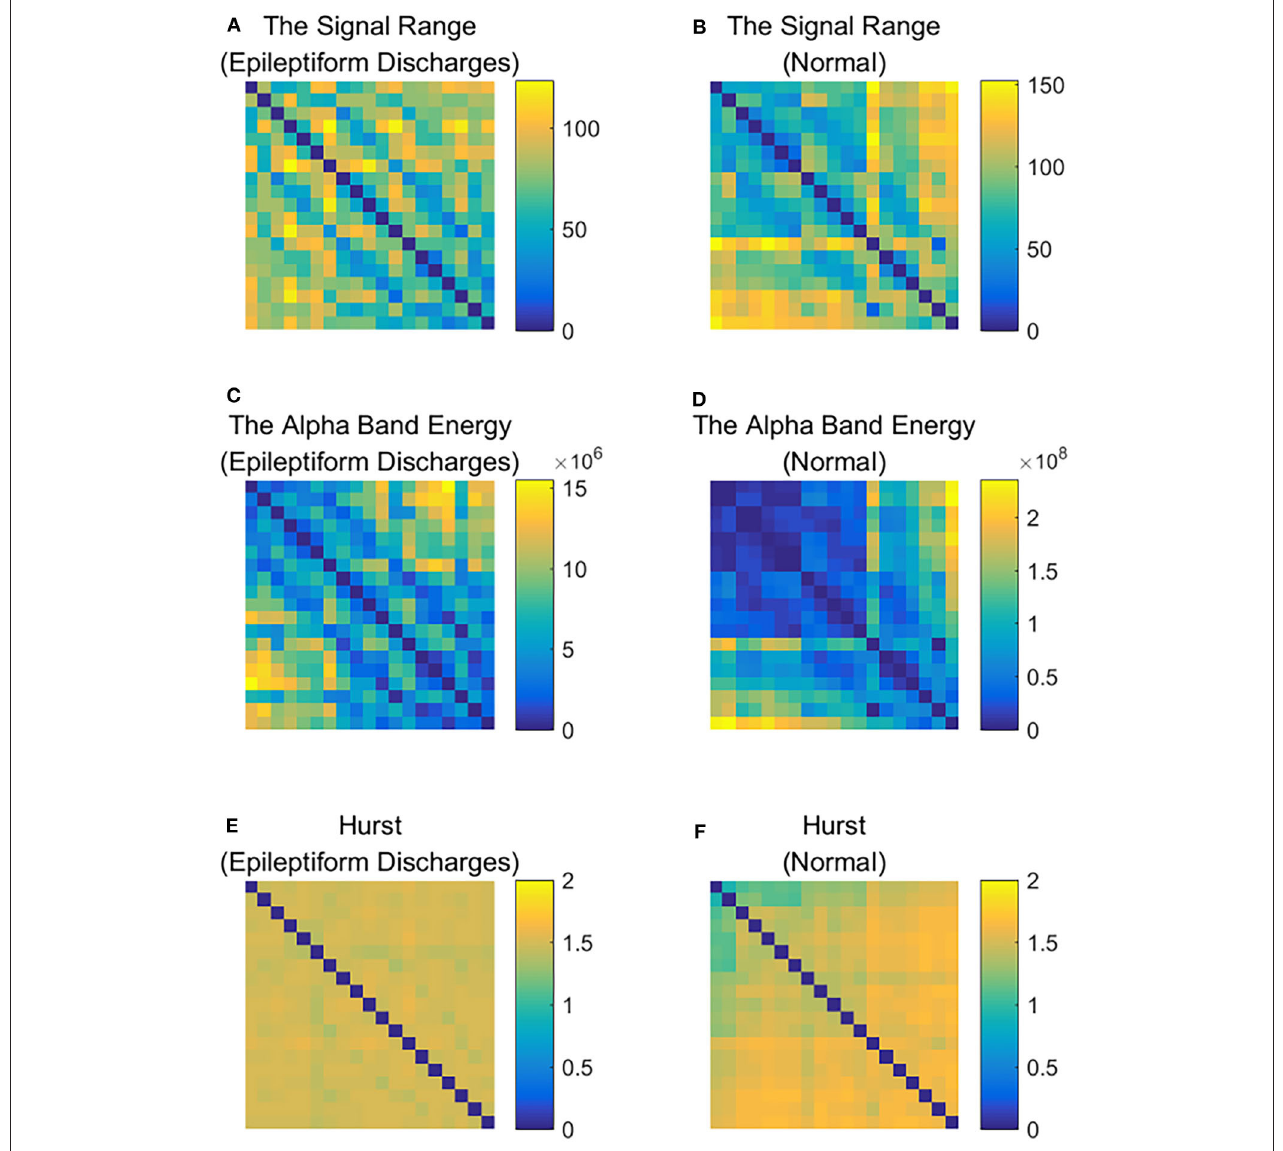
FIGURE 8 | Heat maps illustrating the three types of networks described in section 2: (A,C,E) are for epileptiform discharges while (B,D,F) are for normal